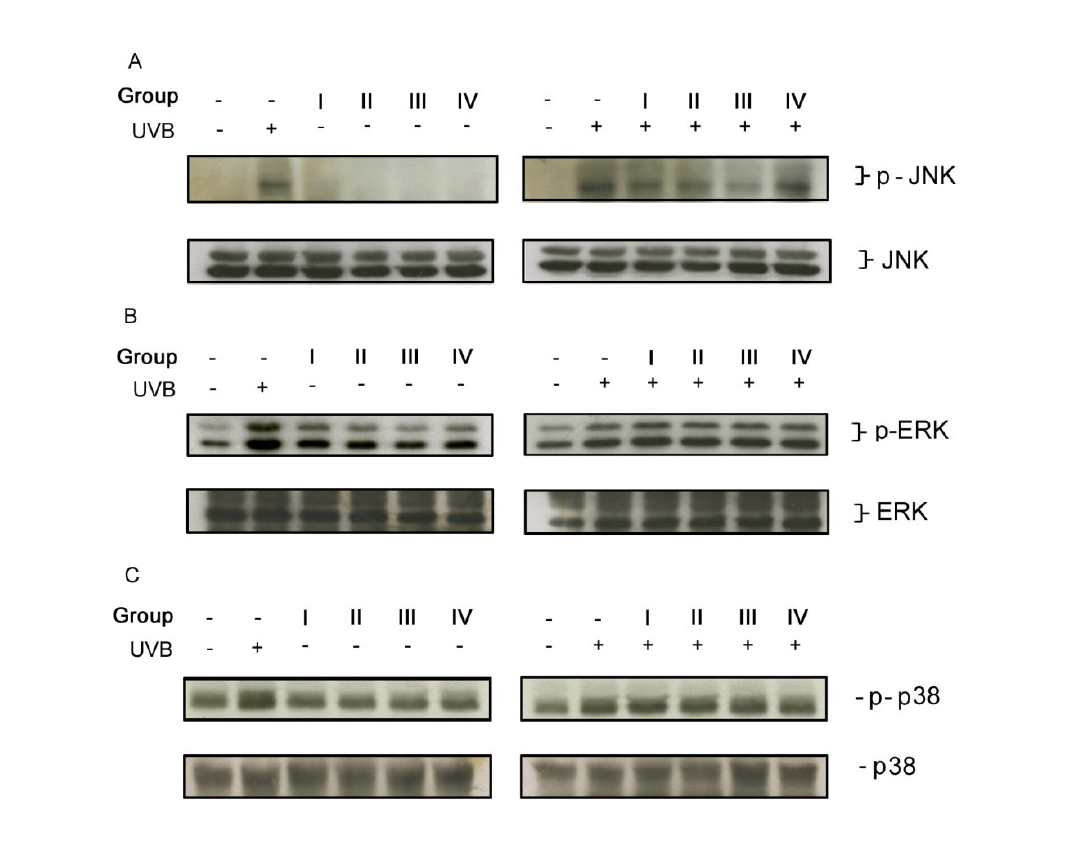
Figure 3. Effect of isoflavone extracts on UVB-induced JNK, ERK and p38 phosphorylation. The results are the representatives of four to six